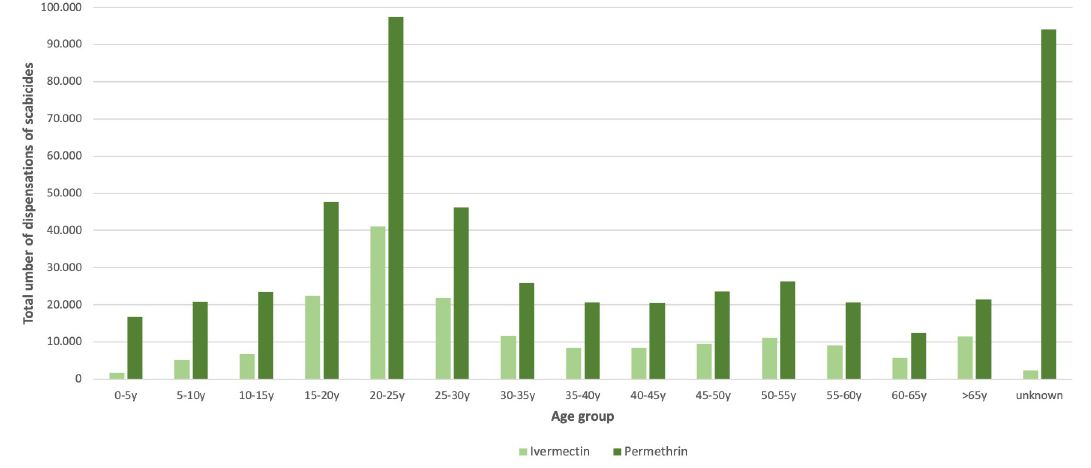
Fig 3. Total number of dispensations of permethrin and ivermectin by age group, 2011–2021, the Netherlands.